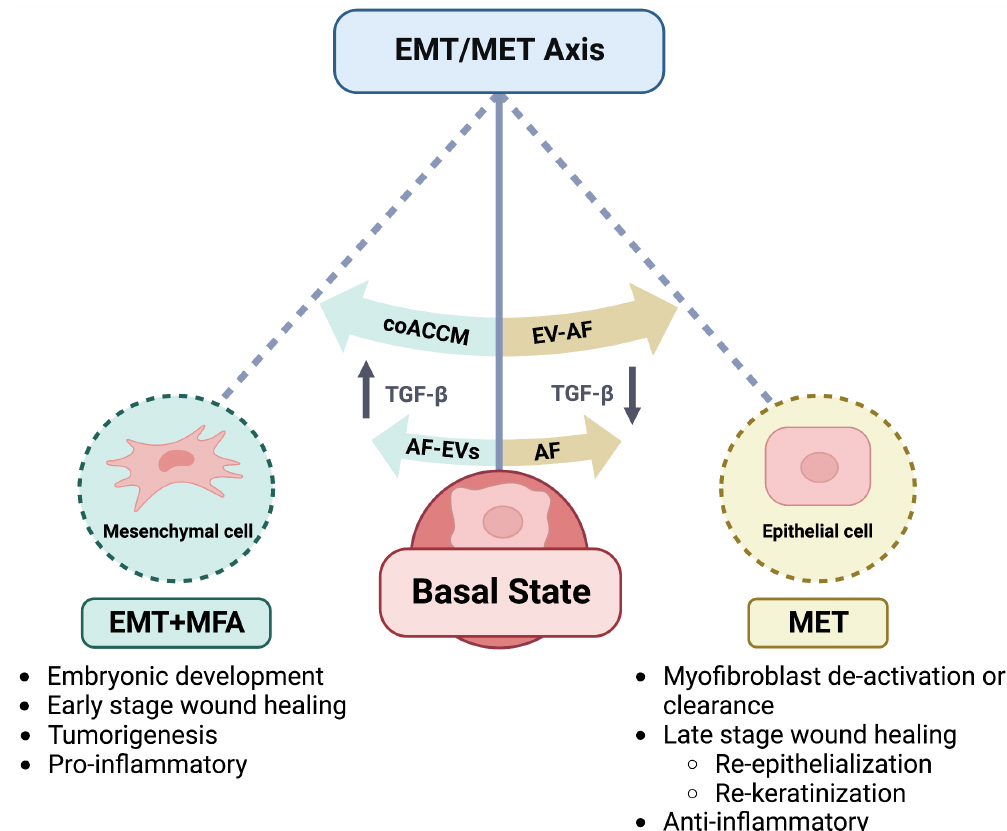
Figure 7. Model and Summary/Conclusion of findings. We use a pendulum as an analogy to represent the EMT/MET axis. The middle represents the basal state of a cell which can be influenced toward EMT and MFA (left) by the addition of TGF-ß, coACCM, or AF EVs), or away from EMT and MFA, toward MET and reduction in MFA (right) by the addition of TGF-ß inhibitor A-83-01, total AF, or EV-AF. EMT is normally observed during embryonic development, and EMT and MFA are normally observed during the early stages of wound healing, and can drive tumorigenesis and pro- inflammatory responses. In contrast, induction of MET and inhibition of MFA and/or myofibroblast clearance is associated with the late stages of wound healing and anti-inflammatory